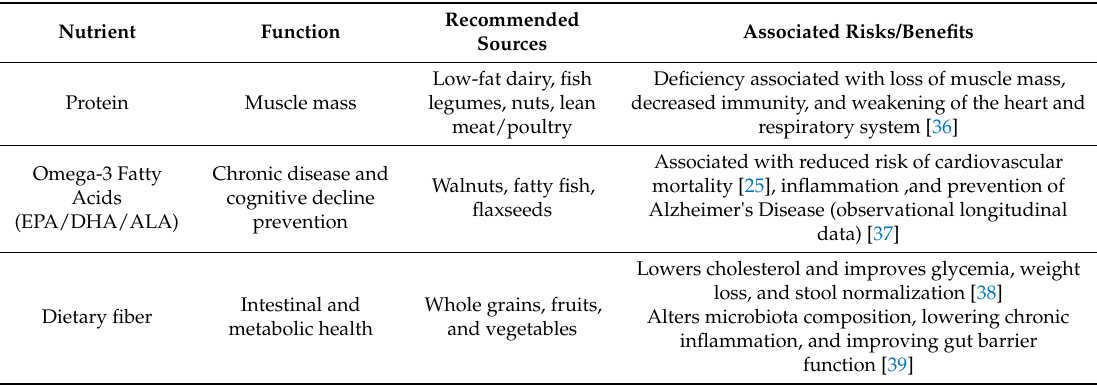
Table 2. Evidence for optimal nutrition in disease and infection prevention in older